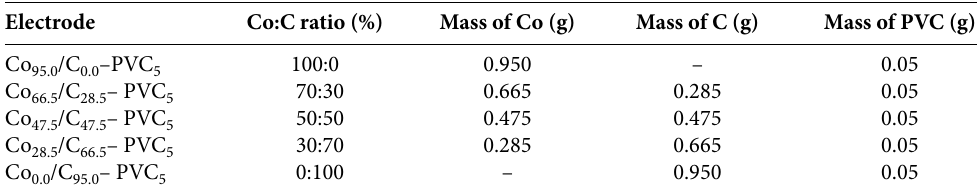
Table 1. The composition ratio and mass of Co, C, and PVC for the preparation of Co/C-PVC electrodes.